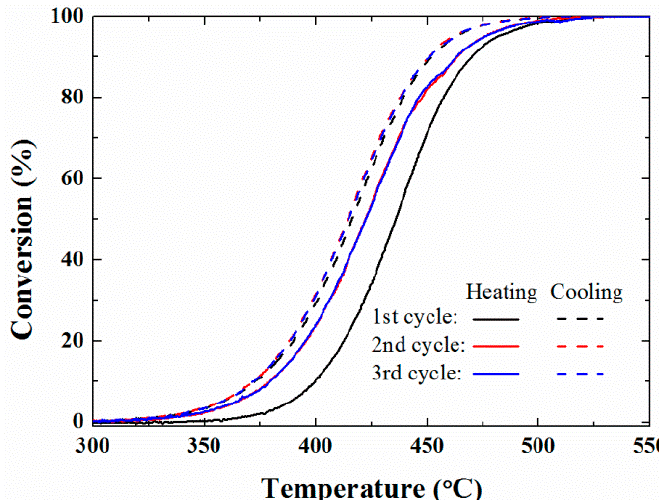
Figure 2. Methane conversions obtained from the cyclic temperature-programed reactions of the Pd/ZrO 2 (700) catalyst. The reaction was performed under a constant reactant composition of 10% H 2 O/0.1% CH 4 /3.15% O 2 /N 2 balance with a total flow rate of 400 cm 3 /min (GHSV = 240000 cm 3 g cat − 1 h − 1 ). GHSV was defined as total flow rate of reactants (cm 3 h -1 )per the weight of catalyst used (g catalyst). Table 1. Physicochemical properties of the ZrO 2 support and the Pd/ZrO 2 (x) catalysts, as determined by XRD, CO chemisorption, and N 2 sorption measurements.